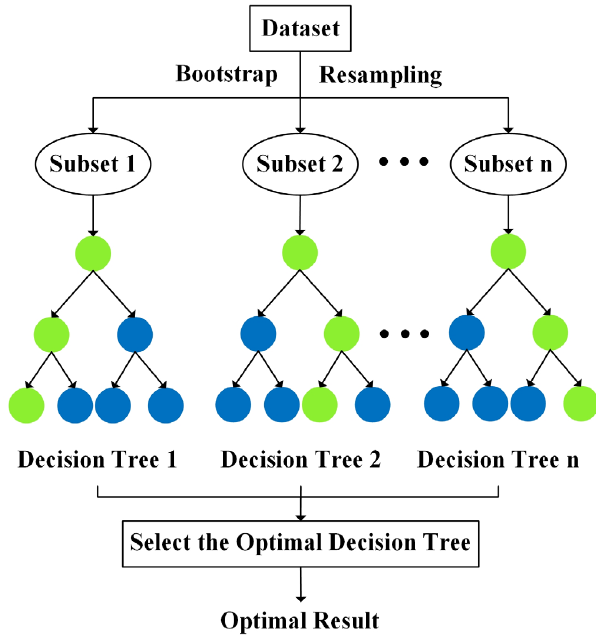
Figure 4. ORFR Model Structural Framework.